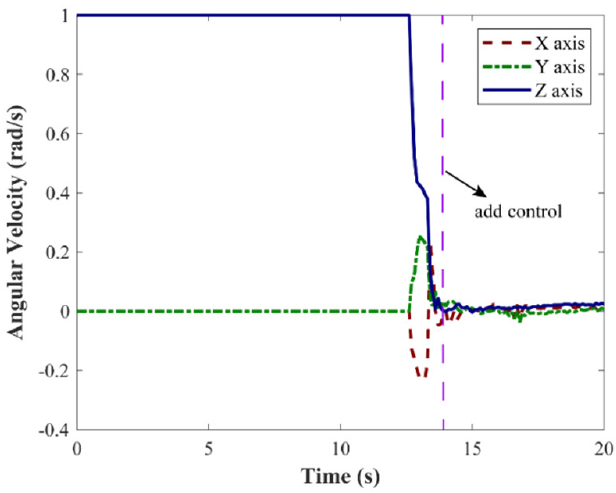
Figure 11. The angular velocity variations of the debris.